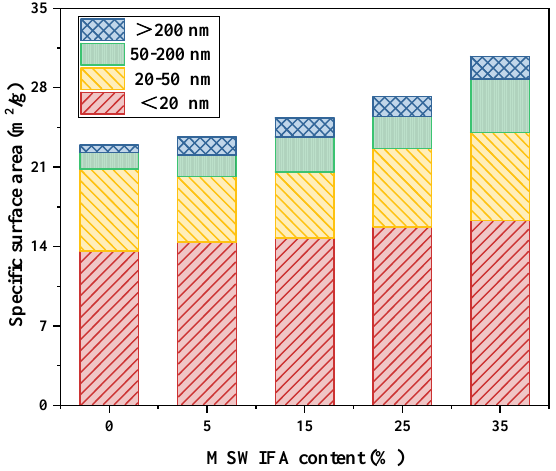
Figure 6. The specific surface area distribution of geopolymer mortars.